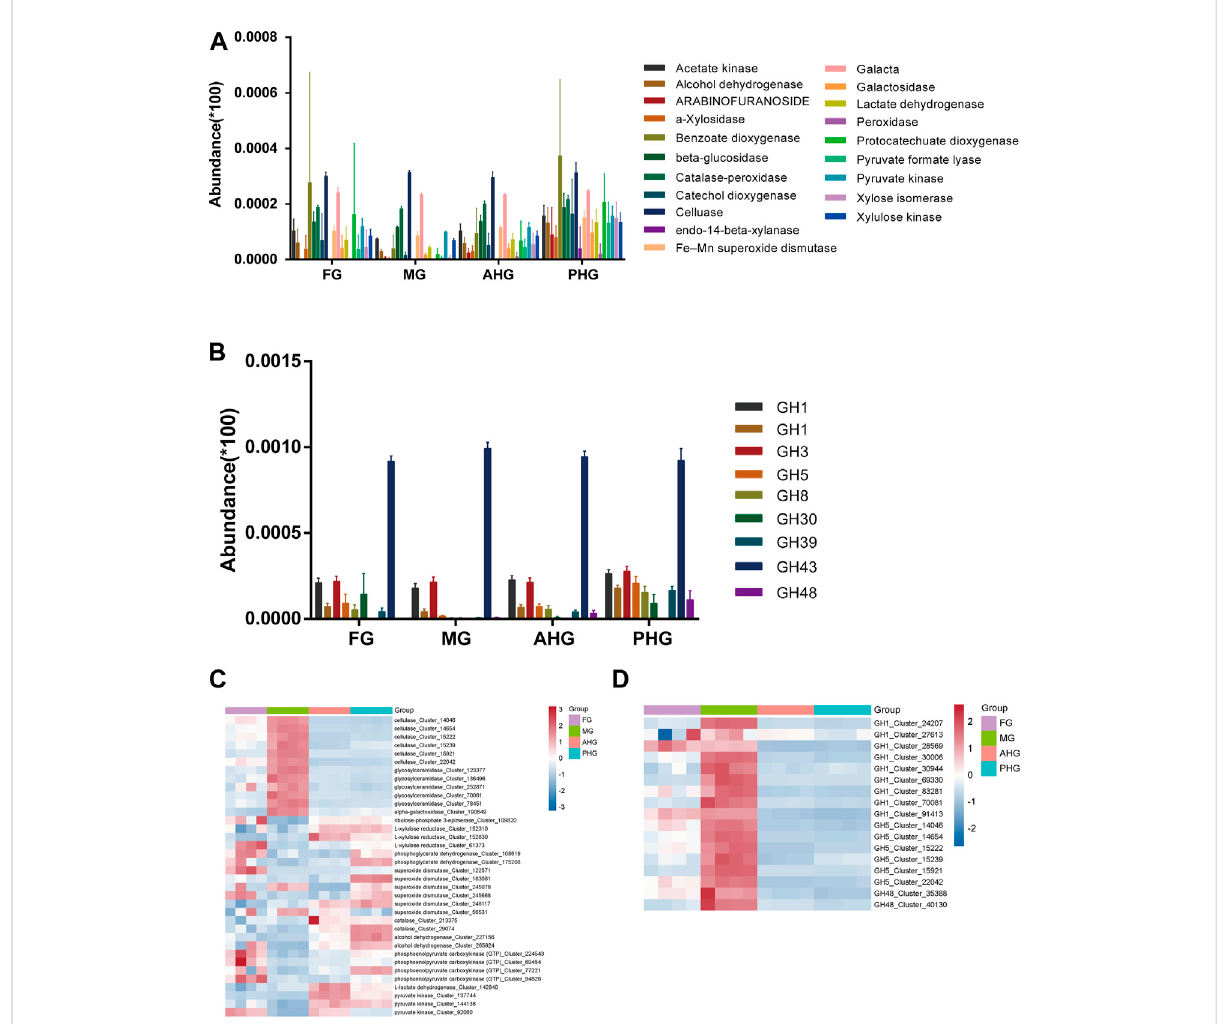
FIGURE 4 Comparativeanalysisoflignocellulosedegradation-relatedgenesandproteinsinfourgutsegmentsof A.swainsoni larvae. (A) Genescodingfor different enzymes involved in lignocellulose degradation were detected through the four gut regions of four A. swainsoni larvae, with the highest abundance levels detected at the PHG. (B) Genes coding for glycoside hydrolases (GH) enzymes were detected through the four gut regions of four A.swainsoni larvae,withthehighestabundancelevelsdetectedatthePHG. (C,D) .Metaproteomicsurveyidenti fi edexpressionoflignocellulose degradation enzymes (C) , and 3 GH enzyme (D) distributed through the beetle gut with the highest expression level at